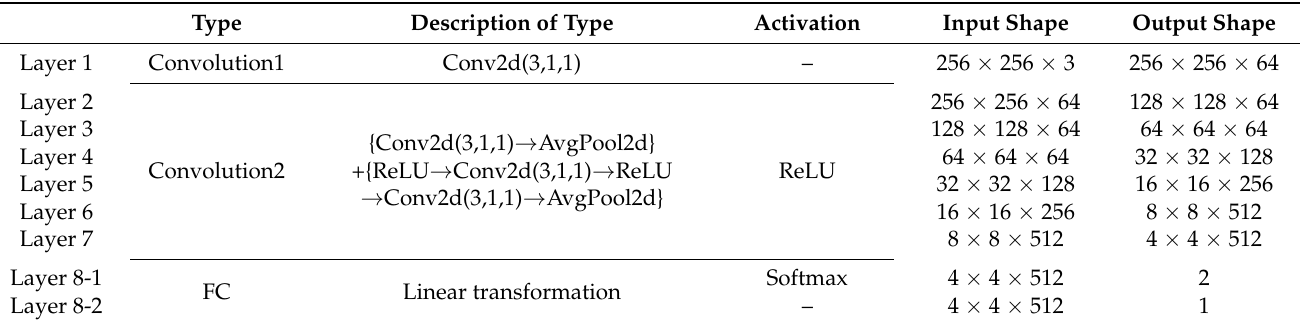
Table 2. Discriminator architecture of CR-GAN for 256 × 256 image